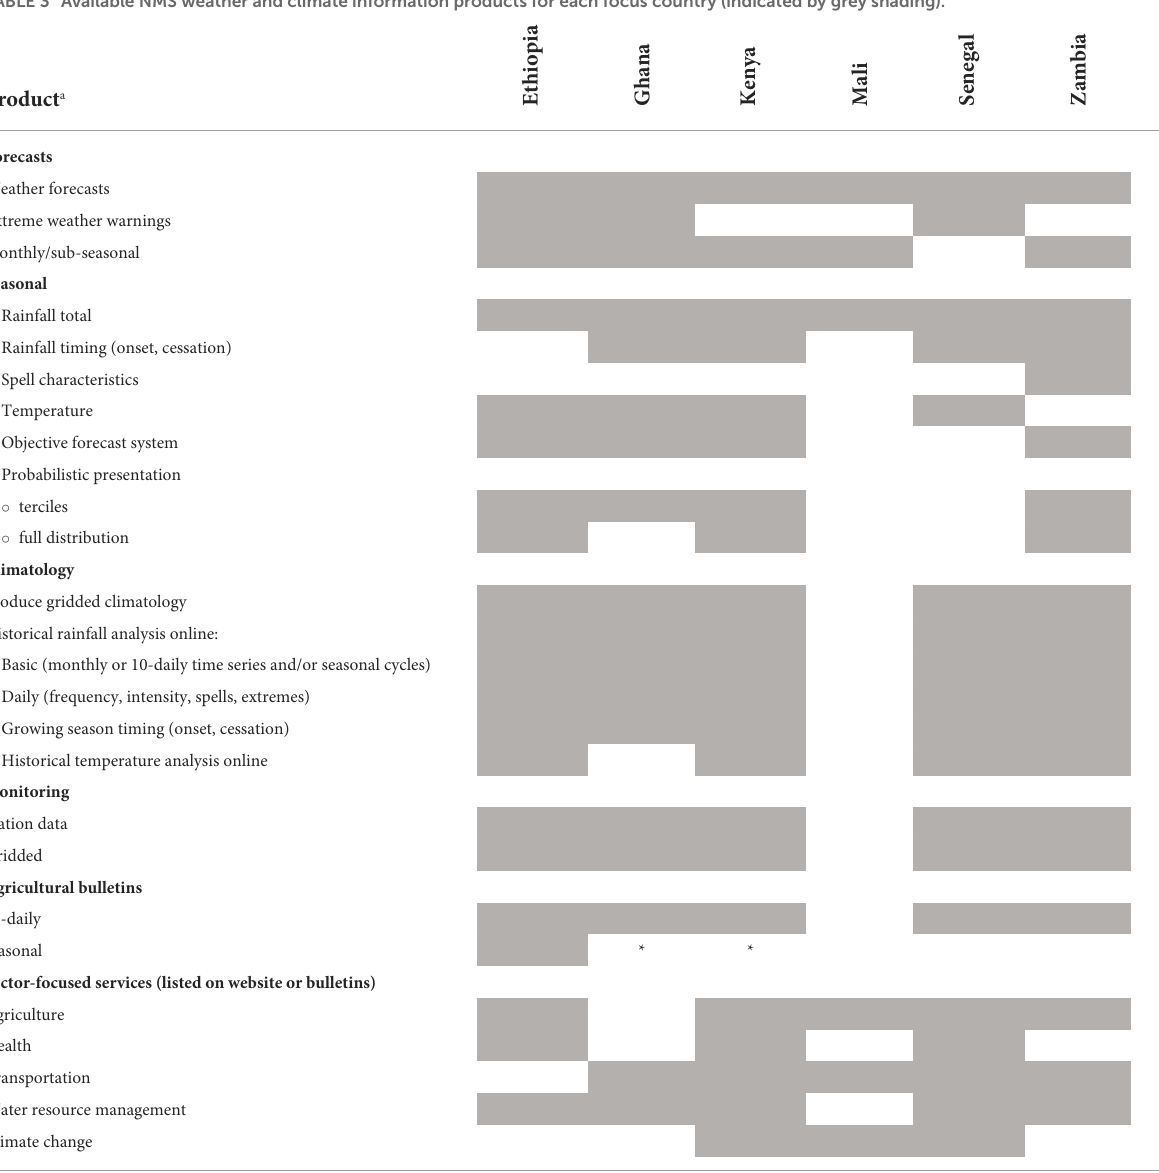
TABLE 3 Available NMS weather and climate information products for each focus country (indicated by grey shading).